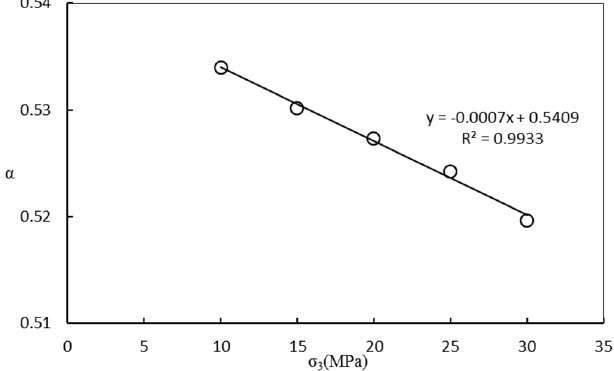
Figure 8. Relationship between calculated effective stress coefficient and confining pressure.